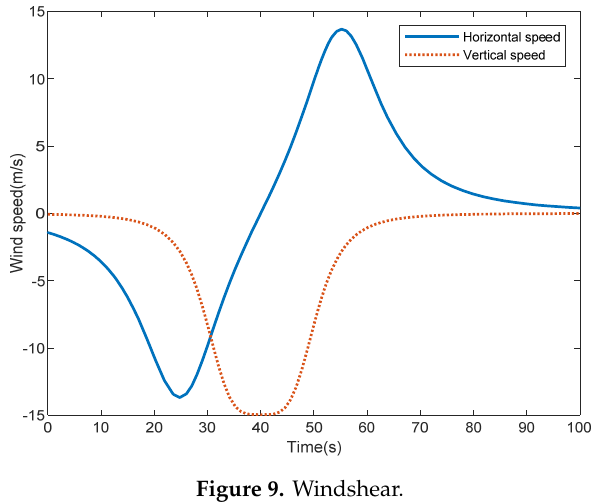
Figure 9. Windshear.